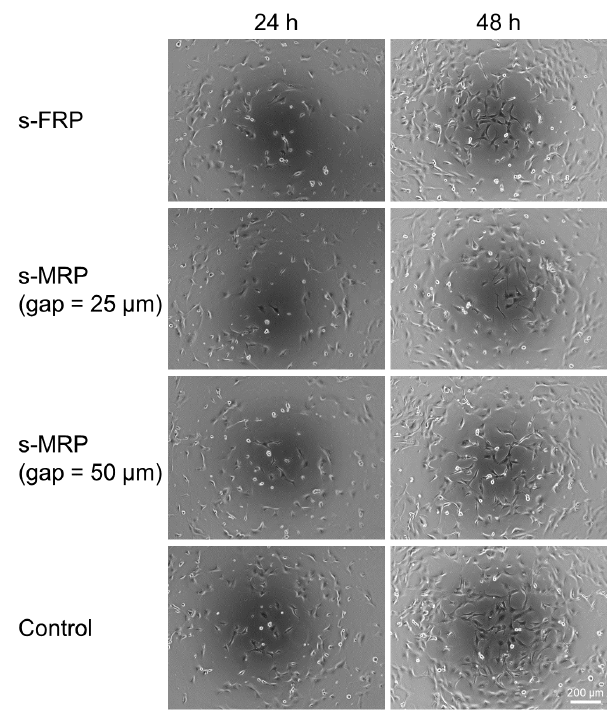
Figure 6. Phase-contrast microscopy images of cultured cells which were sent with the s-FRP and s-